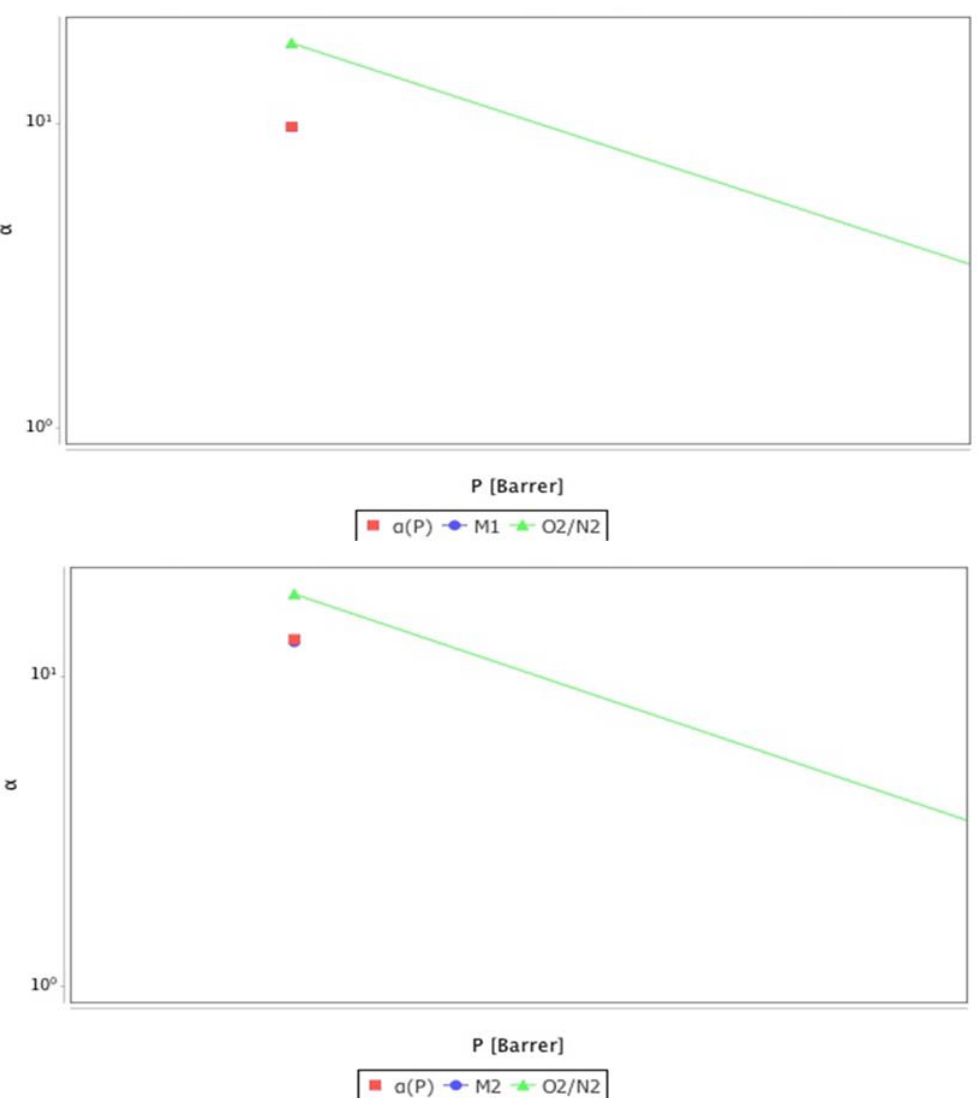
Figure 5. Comparison of experimental results (navy blue point) for the zeolite 4A-2, 2 ′ -BAPB + BPADA mixed-matrix membranes with 3 different filler additions (M1, M2 and M3) with Maxwell theoretical results (red point) and their position relative to the Robeson upper bound line (green line).